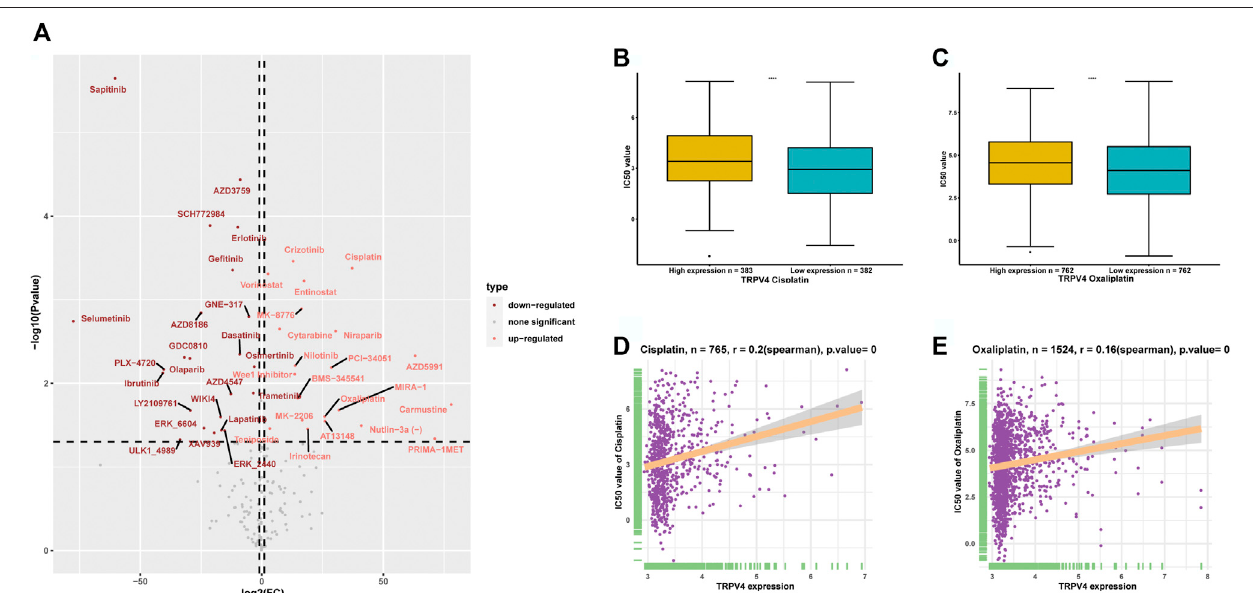
FIGURE 8 | Anti-cancer drug sensitivity analysis. (A) Volcano map representing the differences in IC 50 values of anti-cancer drugs between high- and low-TRPV4 groups. (B) IC 50 values of cisplatin in high- and low-TRPV4 groups. (C) IC 50 values of oxaliplatin in high- and low-TRPV4 groups. (D) The correlation between TRPV4 expression and IC 50 values of cisplatin. (E) The correlation between TRPV4 expression and IC 50 values of oxaliplatin. The spearman ’ s correlation coef fi cient was calculated using R